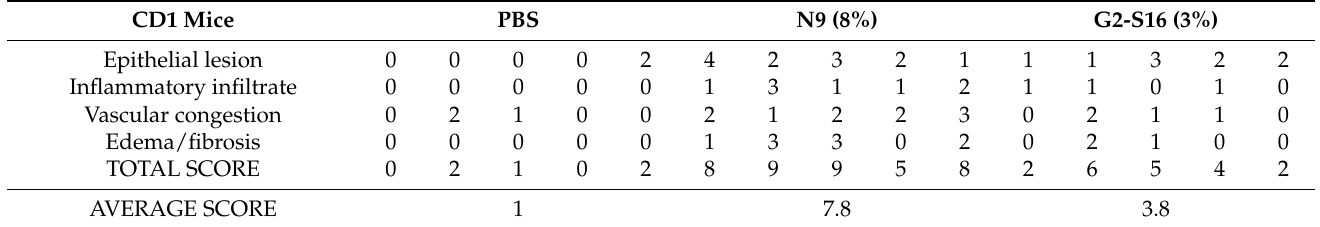
Table 2. Evaluation of tissue damage. Results of CD1 mice after daily treatment with G2-S16 dendrimer for 14 consecutive days by vaginal